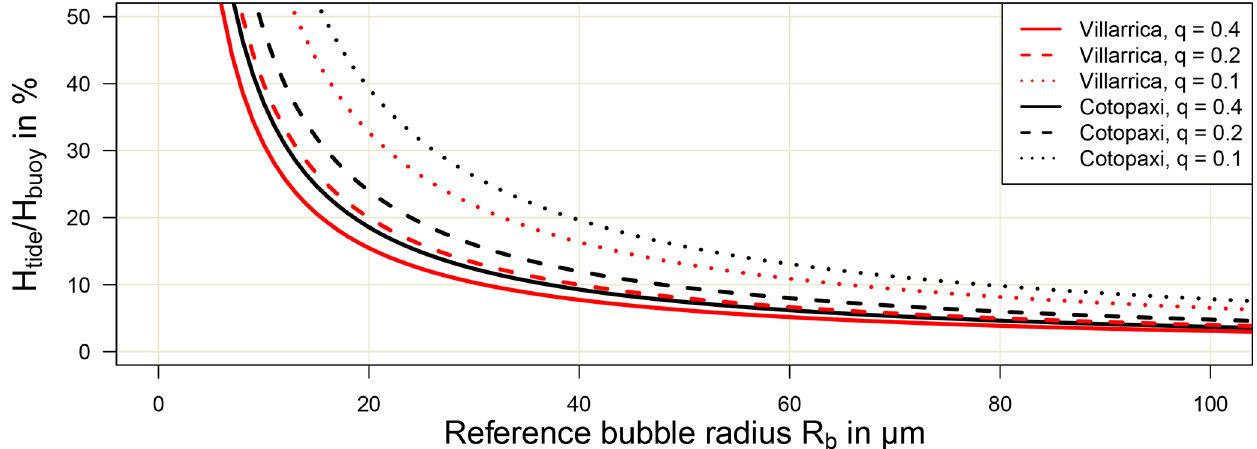
Figure 2. Relative contribution of the tidal mechanism (magnitude given by H tide ) on the bubble coalescence rate for a purely separated bubble flow (magnitude given by H buoy ) depending on the reference bubble radius R b and the degree of polydispersity q . The reference bubble radius is reciprocally linked to the depth of the particular magma